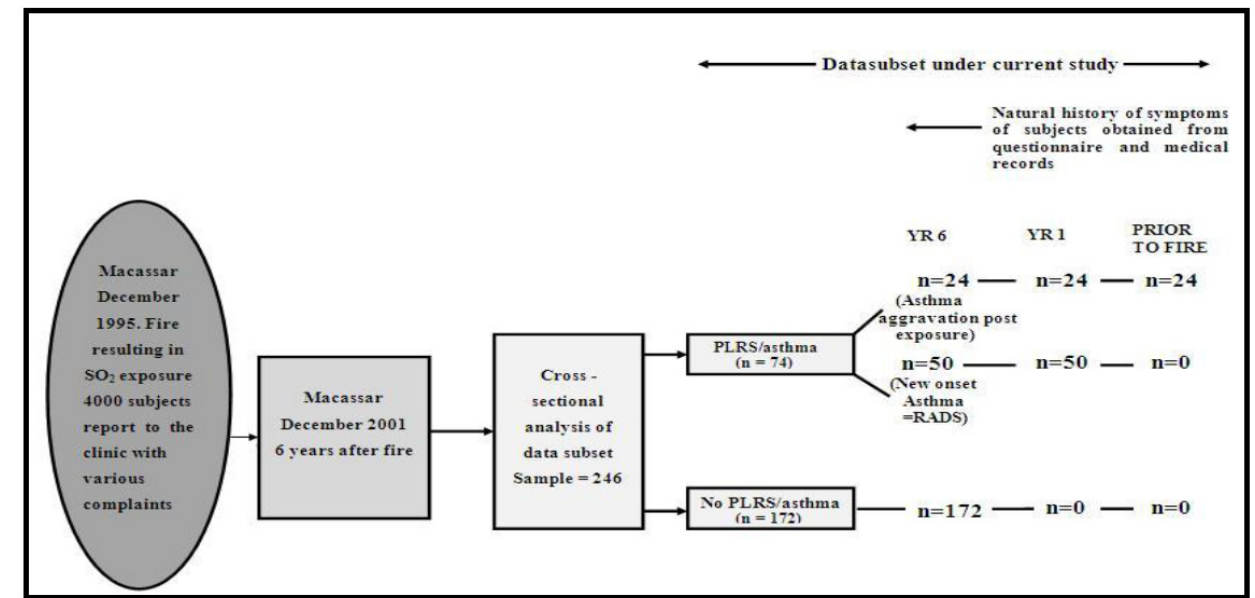
Figure 1. Sample of participants affected by the sulphur stockpile fire incident included in the study.